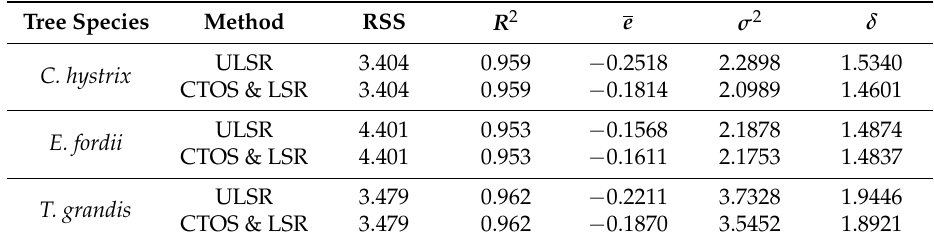
The statistics of Equation (1) fitted by the combination method of constrained two-dimensional optimum seeking and least square regression (CTOS & LSR) and the unconstrained least square regression (ULSR) for three trees species ( C. hystrix , E. fordii, and T. grandis ) based on cross-validation